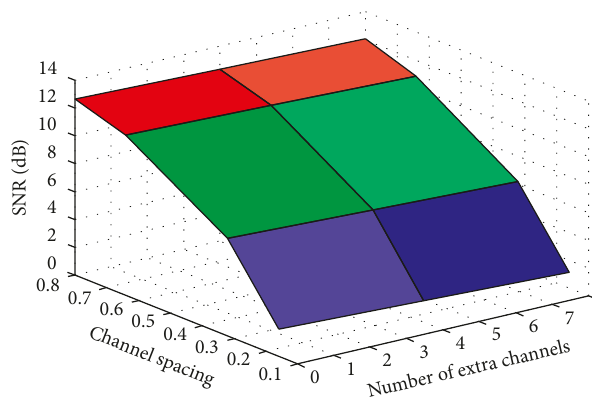
Figure 11: SNR with channel spacing and extra